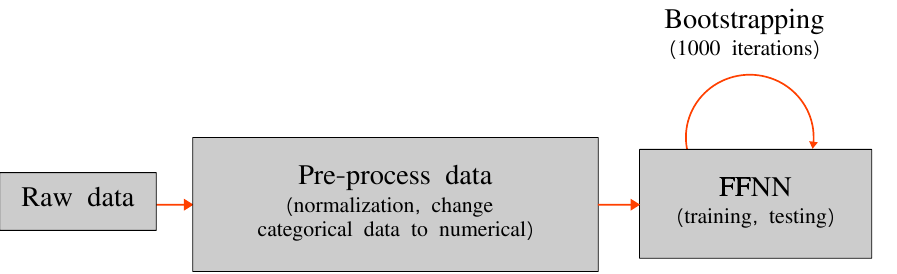
Figure 3. The methodology followed in developing the algorithms for speed prediction. In the pre-processing step, we change the categorical to numerical values and normalize the data between [ 0,1 ] to have the same scale of values (an important step before training for artificial neural